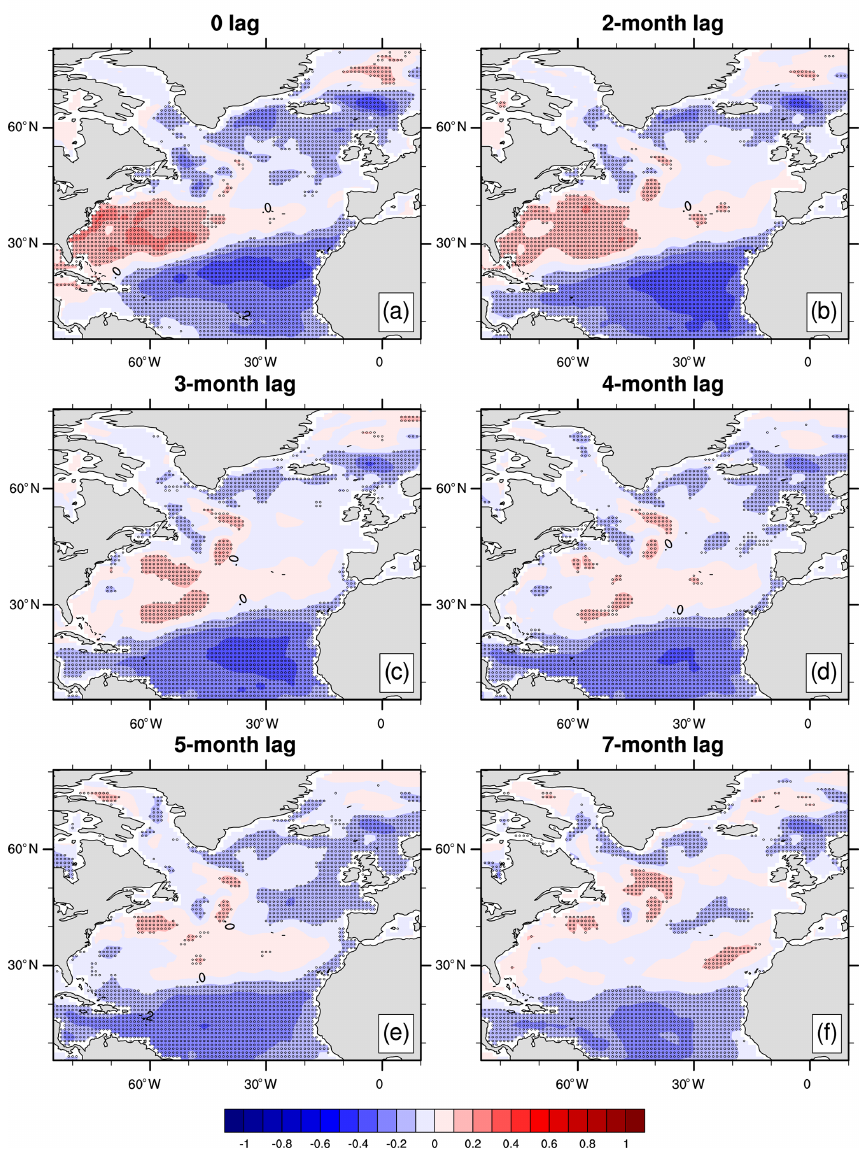
Figure 3. Lagged correlations between the AMOC at 26 ◦ N and North Atlantic SSTAs during 1979–2014, with the AMOC leading ( a–f , as labelled) in the assimilation experiment. The stippling represents significant correlations at the 95% confidence level, calculated from 1000 bootstrap